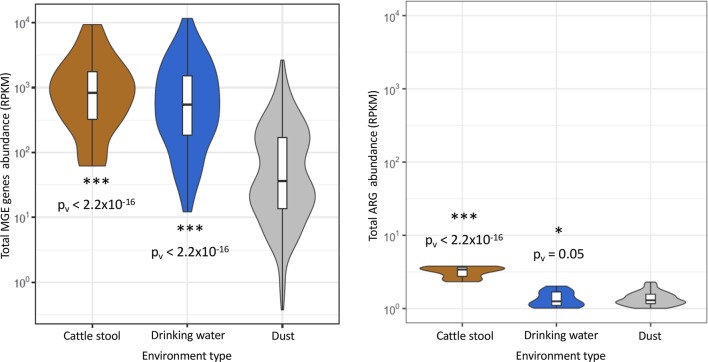
Dust contains few ARGs and mobilizable elements relative to animal gut and drinking water metagenomes.We compared total MGE abundances (sum of all mobilizable gene families from HUMAnN2 [43] profiles and total ARG abundances (sums from ShortBRED [41] profiles) between dust metagenomes and two other datasets: 13 livestock stool samples from Hu et al., 2016 [2] and 25 drinking water metagenomes from Ma et al., 2018 [4]. Animal guts and drinking water had significantly more total MGEs than dust, and animal stool had (as expected) significantly more total ARGs. P-values are shown from Mann-Whitney tests relative to dust distribution.